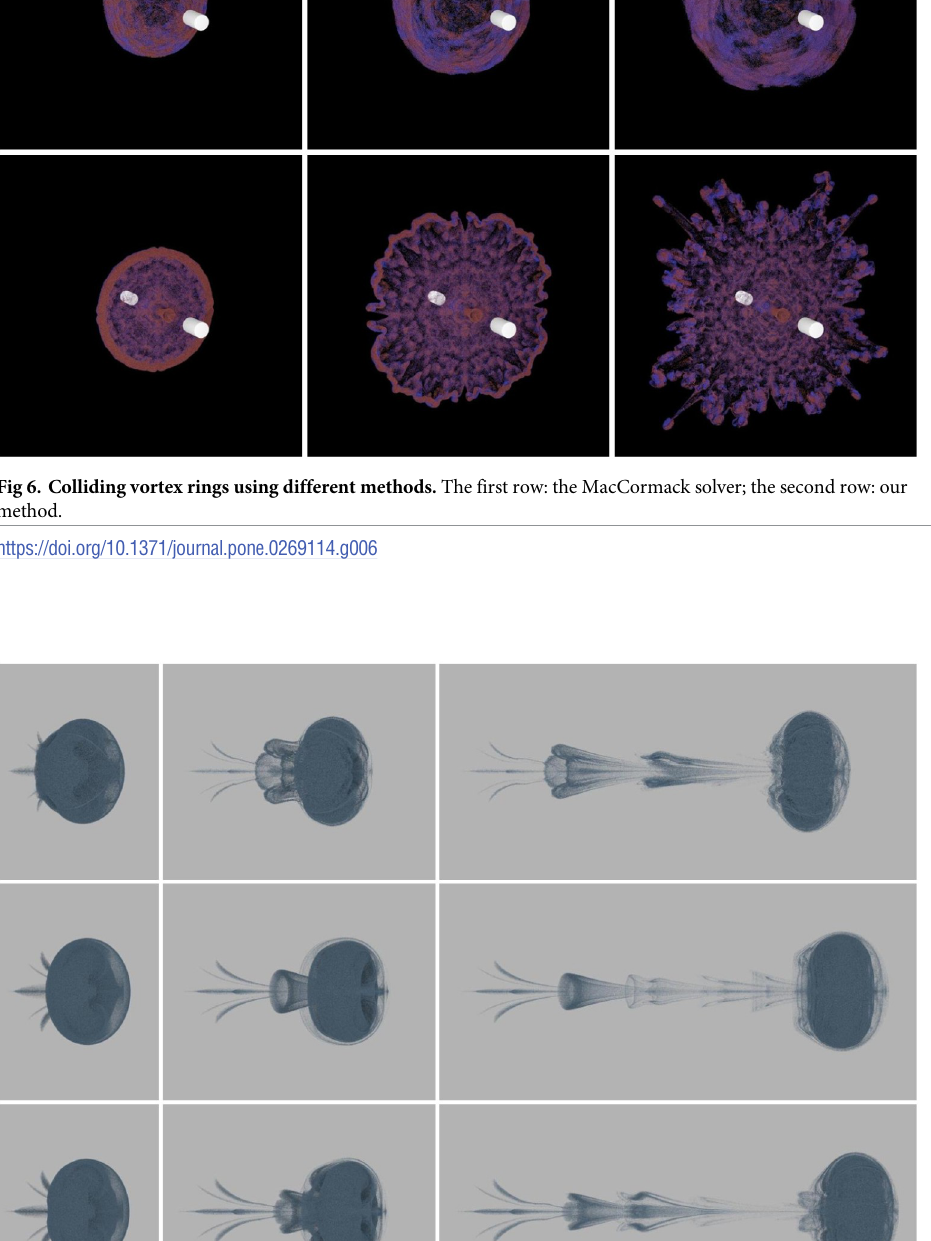
PLOS ONE | https://doi.org/10.1371/journal.pone.0269114 June 16,